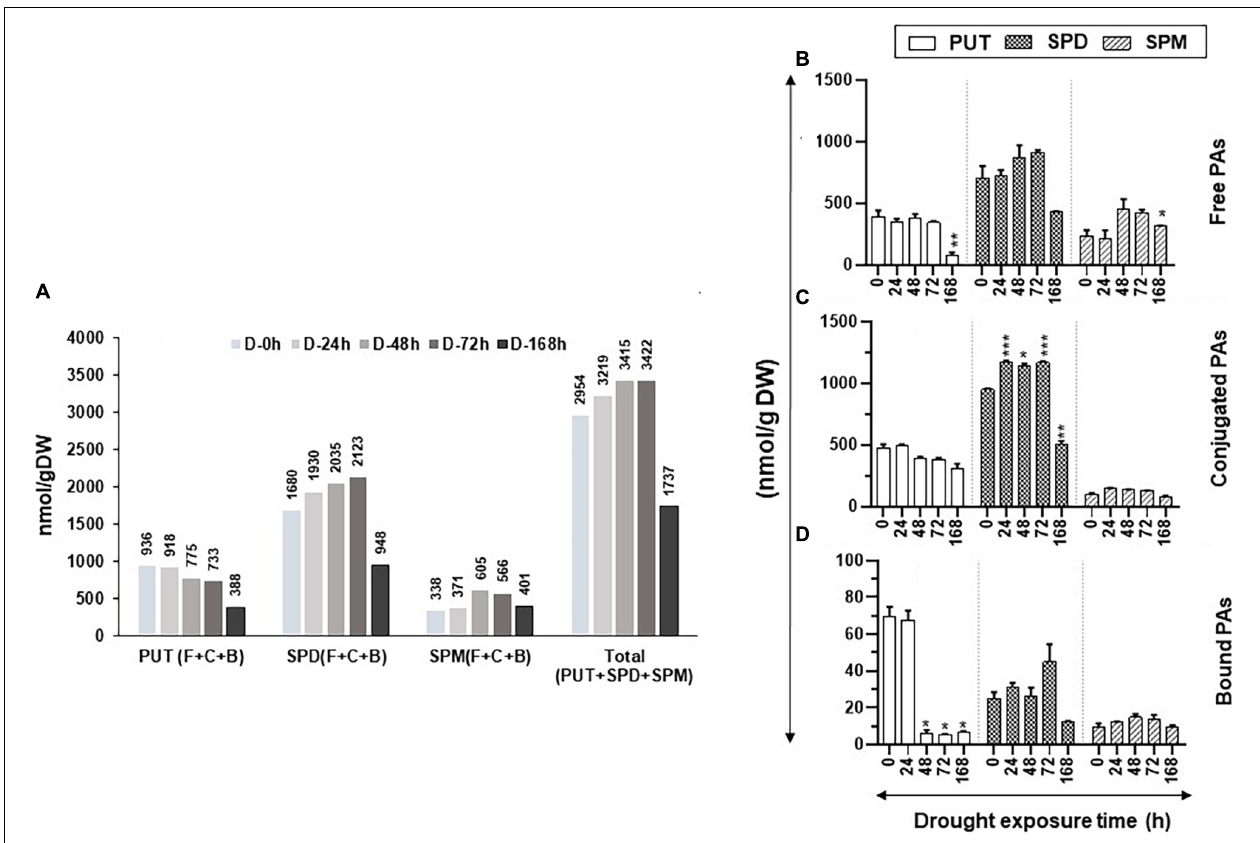
FIGURE 1 | Changes in the levels of free, conjugated, and bound forms of putrescine (PUT), spermidine (SPD), and spermine (SPM) during drought stress in tomato leaves. The drought stress was imposed on tomato plants by withholding water. Leaf samples from a minimum of three plants were harvested at the indicated time periods and immediately frozen in liquid N 2 and then stored at –80 ◦ C until analyzed. High-pressure liquid chromatography (HPLC) was used to determine the levels of free, bound, and conjugated forms of polyamines (PAs) as described in the Materials and Methods section. (A) Changes in the total amount of free, bound, and conjugated PUT, SPD, and SPM under drought stress; (B) free PUT, SPD, and SPM; (C) conjugated PUT, SPD, and SPM; (D) bound PUT, SPD, and SPM, respectively, during the increasing period of drought stress. Shown are mean + STE from three independent biological replicates. Statistical significance ( p -value) was derived using the Graph prism pad program via Tukey test/ t -test. *, **, *** indicate significance at p -value < 0.05, < 0.005, and < 0.0005,